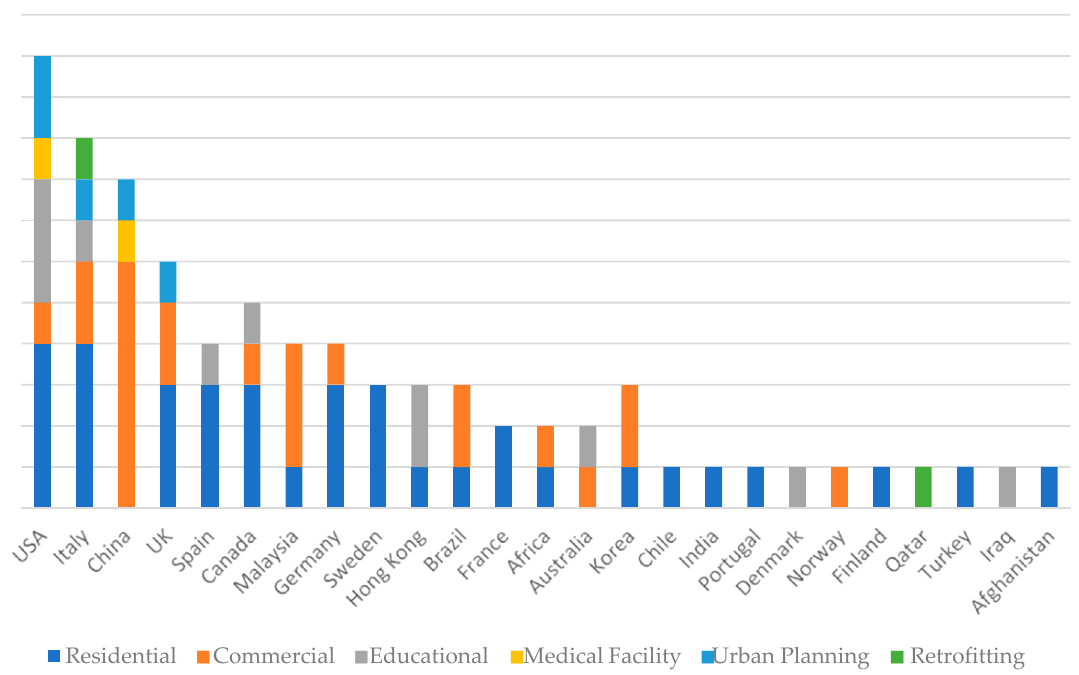
Figure 3. BIM implementation in different countries in various types of